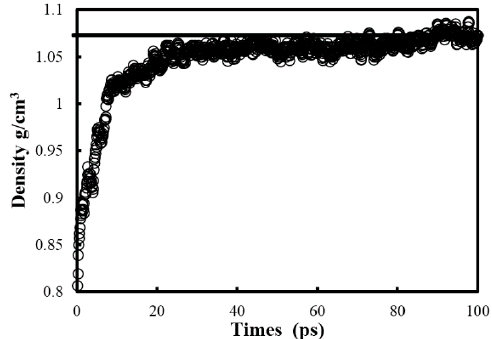
Figure 3. Simulated 3D size of kerogen.